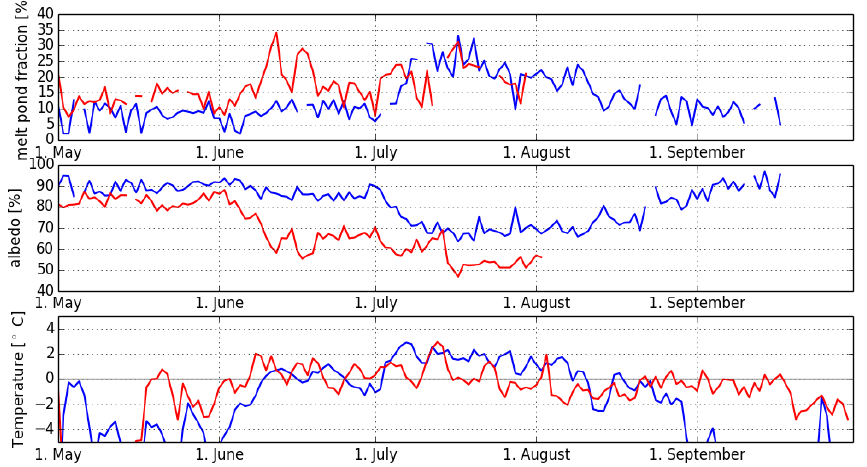
Figure 2. Time sequence of MPF, broadband albedo and NCEP air temperature at the surface for two regions: FYI area in Beaufort Sea near Barrow (75 ◦ N, 155 ◦ W, shown in red) and MYI area around North Greenland (84.5 ◦ N, 35 ◦ W, shown in blue) May to September 2009. Locations are shown in Fig. 1 with white circles tagged “FYI” and “MYI”, respectively. The albedo and MPF curves in the FYI area are interrupted as the area becomes completely ice free on the 1st of August